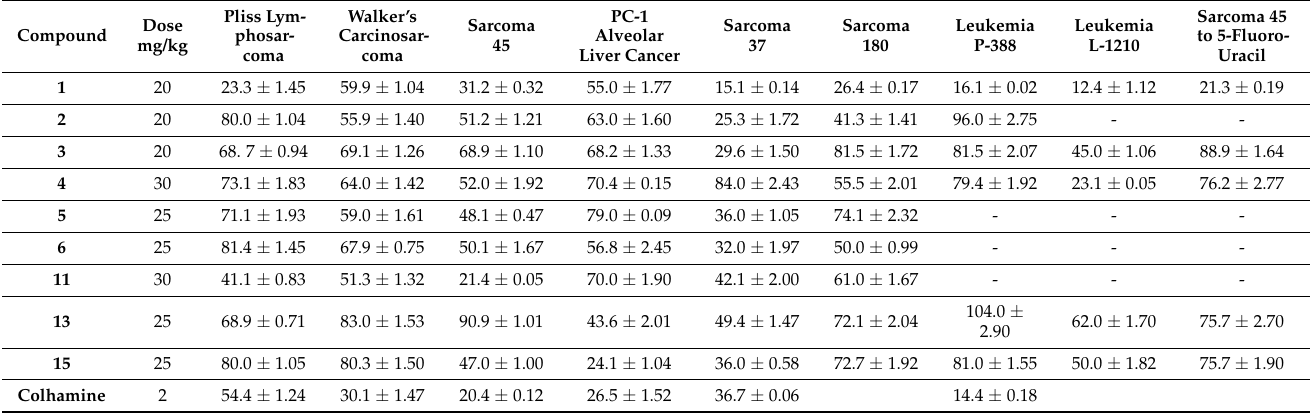
Table 7. Antitumor activity on transplanted tumor strains of estafiatin 1 and its